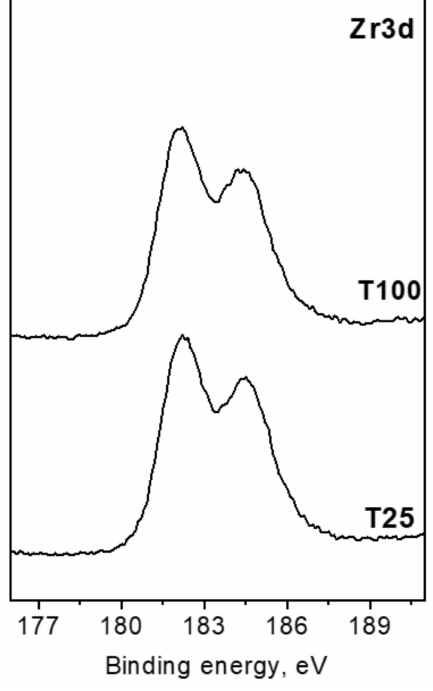
Figure 4. Zr3d core level spectra of chitosan-ZrO 2 multilayers.